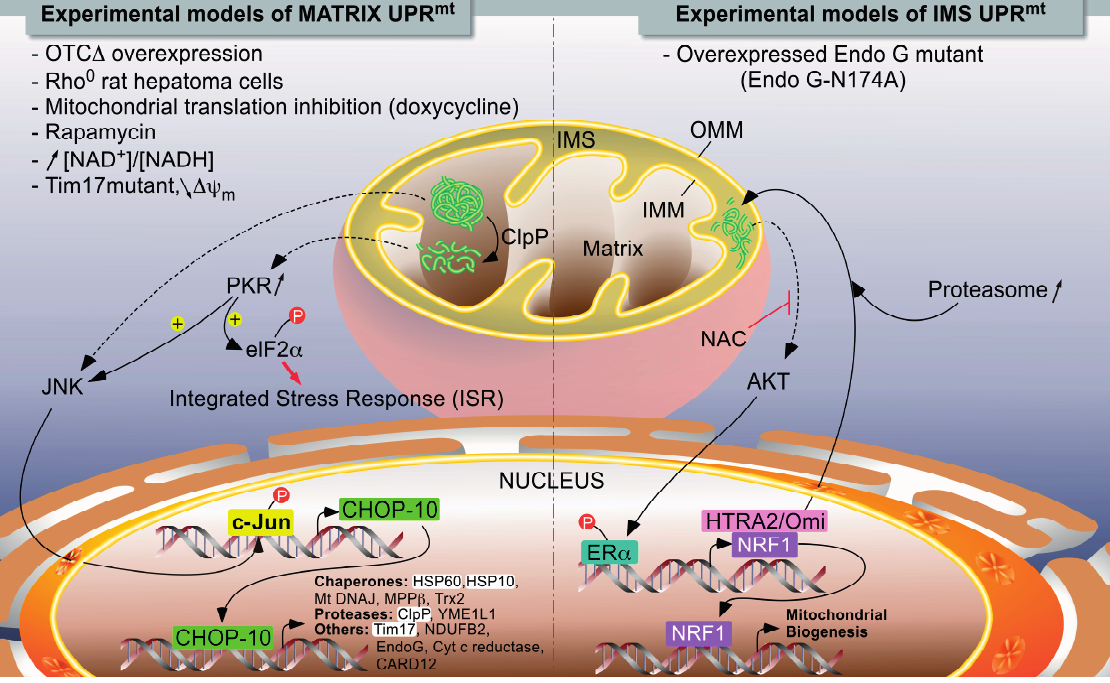
Figure 1. The UPR mt models in mammalians. Two major independent models of UPR mt have been described. When unfolded proteins accumulate in the mitochondrial matrix, they are first cleaved by ClpP proteases. Peptides exit mitochondria by unknown mechanisms and trigger a signaling pathway, leading to the activation of c-Jun N-terminal kinase (JNK) and PKR, which phosphorylate as c-Jun (part of AP-1 transcription factor) and eIF2 α , respectively. The phosphorylation of eIF2 α can also be mediated by GCN2 in response to mitochondrial translation inhibition (not illustrated), and it turns on the integrated stress response (see Figure 2). PKR could also activate JNK. The activation of c-Jun triggers CHOP-10 expression. In turn, the transcription factor regulates the expression of stress-resolving genes such as mitochondrial proteases and chaperones (left side of the chart). When unfolded proteins accumulate in the inter-membrane space, the UPR mt is mediated by the activation of ER α , triggered by an AKT-dependent phosphorylation. The activation of AKT would then be mediated by oxidative stress, as inhibited by N -acetylcysteine (NAC). Mitochondrial stress resolves by an increase in the expression of HTRA2/Omi protease and enhanced proteasome activity, while the biogenesis of mitochondria is enhanced and under the control of NRF1, a target gene of ER α . The highlighted acronyms represent genes for which an endogenous differential expression (RT-qPCR or Western blot analysis) in response to UPR mt has been experimentally demonstrated to be dependent on CHOP-10; this is in addition to analysis using reporter constructs. The non-highlighted genes refer to genes controlled by CHOP-10 in response to a UPR mt , but only demonstrated using reporter